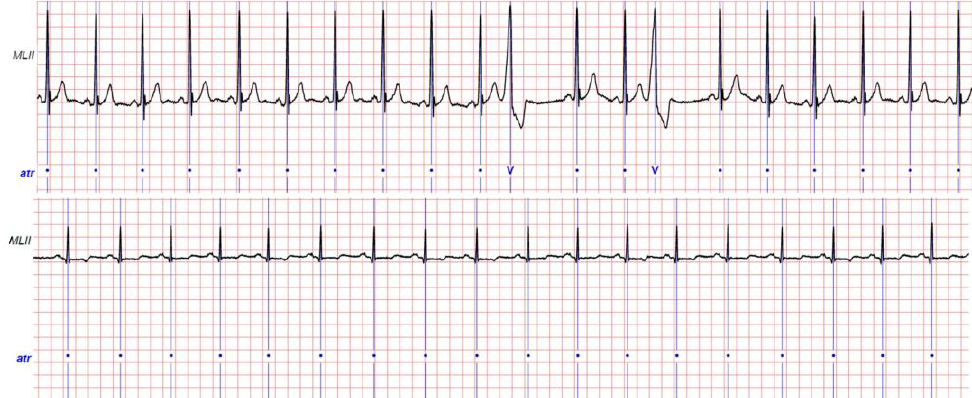
Figure 2. Examples of ECG recordings. (Top) Premature ventricular contraction (V). (Bottom) Normal record.